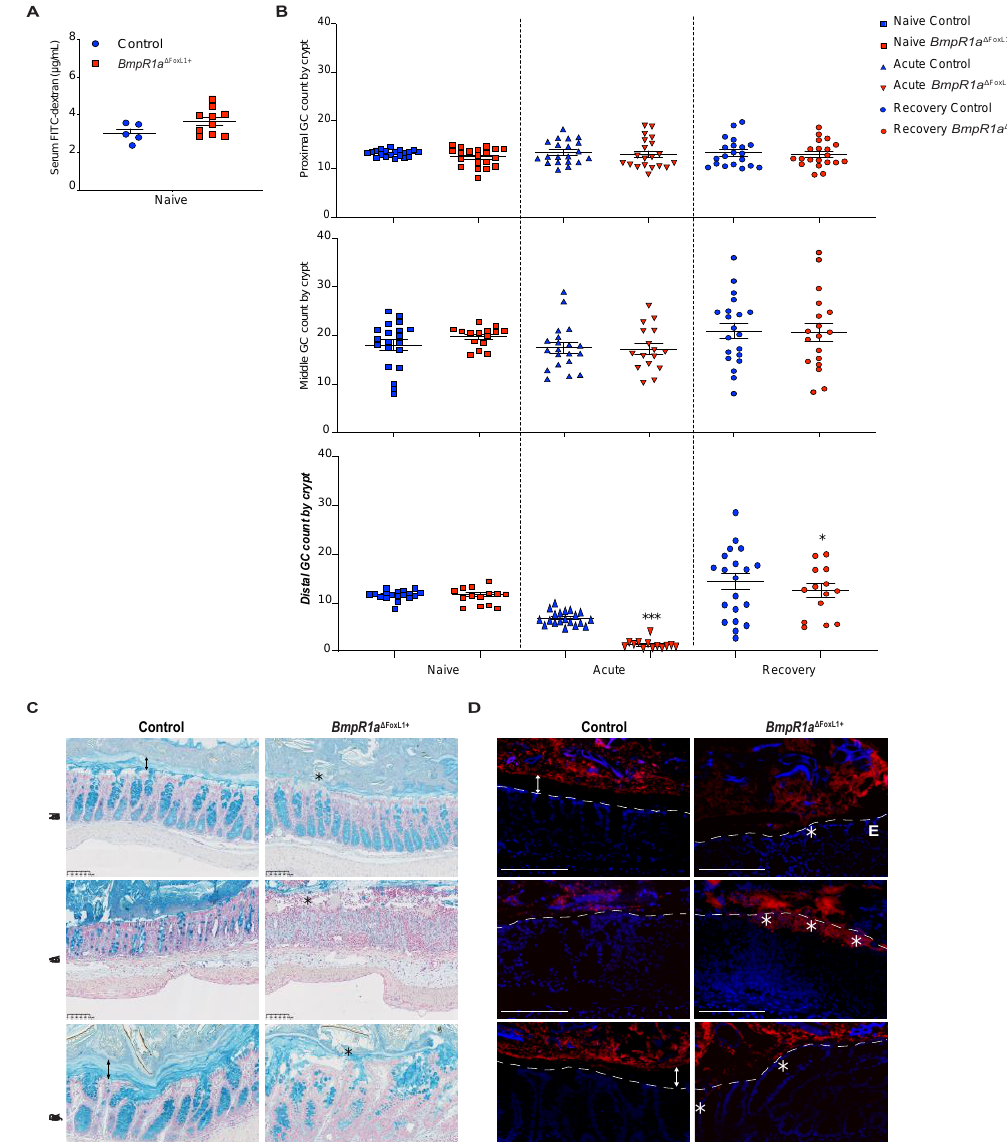
Figure 2. Impaired barrier layer in BmpR1a ∆ FoxL1+ mice resulted in susceptibility to bacterial mucosal invasion. ( A ) No differences in concentration of FITC-dextran were observed in serum of controls and BmpR1a ∆ FoxL1+ mice ( N = 5–10). ( B ) Statistical analysis showed a significant decrease in the number of acidic mucin-positive cells in mutant mice compared with the control, only in the distal colon after both (acute and recovery) treatments; no significant modulation was observed in other colonic sections ( N = 4; n = 20). After the acute phase, there was a 0.2-fold decrease in goblet cells, and 0.8-fold decrease following recovery. ( C ) Under naive conditions, a well-preserved barrier layer (double black arrow) was observed in control mice, whereas in BmpR1a ∆ FoxL1+ mice a discontinuous (black asterisk) and thinner barrier layer was